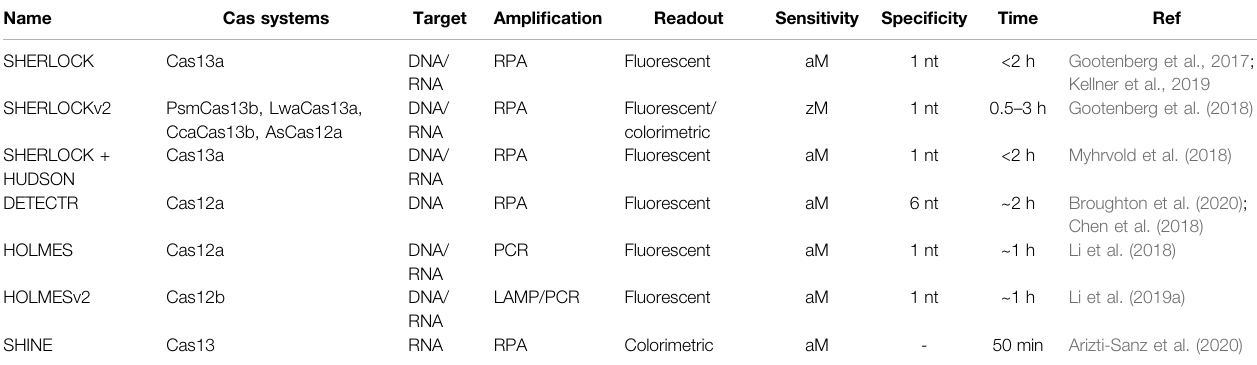
TABLE 3 | Major characteristic of several developed CRISPR-based biosensors for nucleic acid